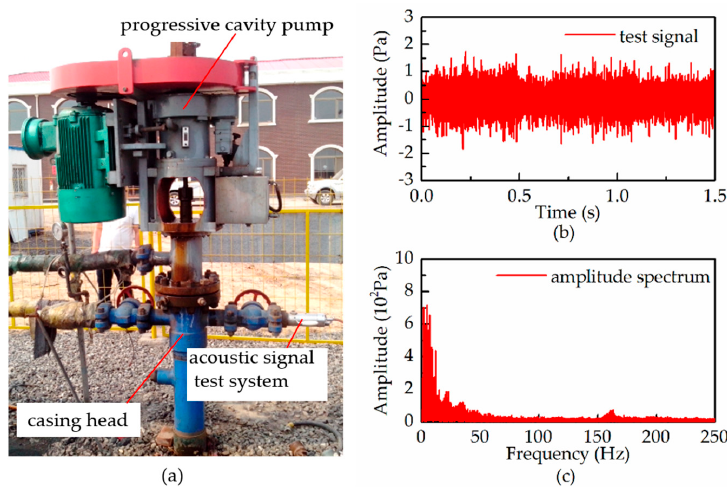
Figure 13. Noise test at the wellhead of CSG wells. Diagram of noise test ( a ); Time domain ( b ) and frequency domain ( c ) of the test acoustic signal.